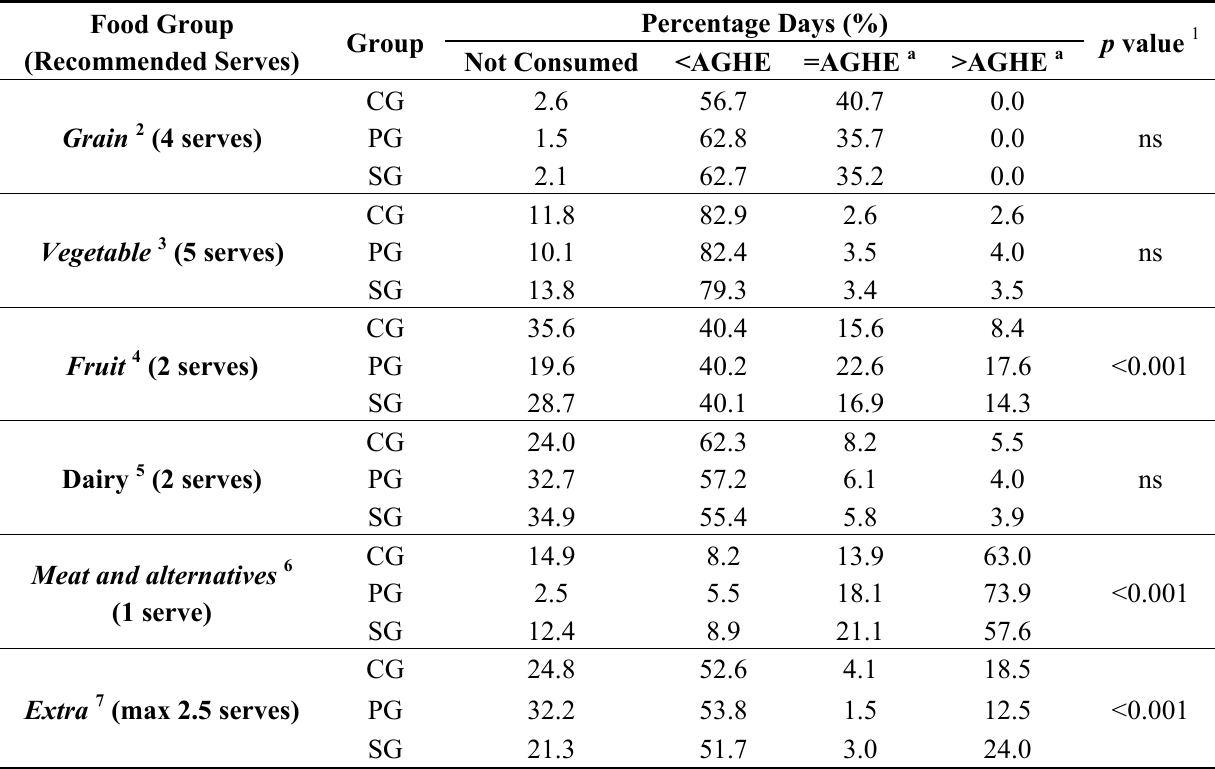
Table 4. Percentage of days during the 21-day collection period that the AGHE food group recommendations were consumed by the control (CG), pork diet (PG) and supplement (SG)